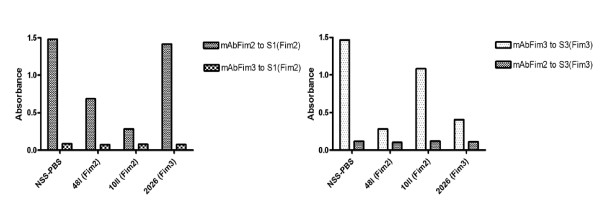
Blocking of binding of mAbFim2 and mAbFim3 to Fim2-expressing strain S1 (left) and of mAbFim3 and mAbFim2 to Fim3-expressing strain S3 (right) by human IgG antibodies to fimbriae. Patients 48I and 10II were infected by Fim2 strains and patient 2026 by Fim3 strain. Blocking of binding of mAbFim2 and mAbFim3 to S1 and S3 by normal sheep serum in PBS (NSS-PBS) was not observed. Data were from a single experiment. Three sera with different blocking levels were tested twice and the results obtained were same. In each experiment, both positive and negative controls were included, and all the experiments were performed by an experienced technician.